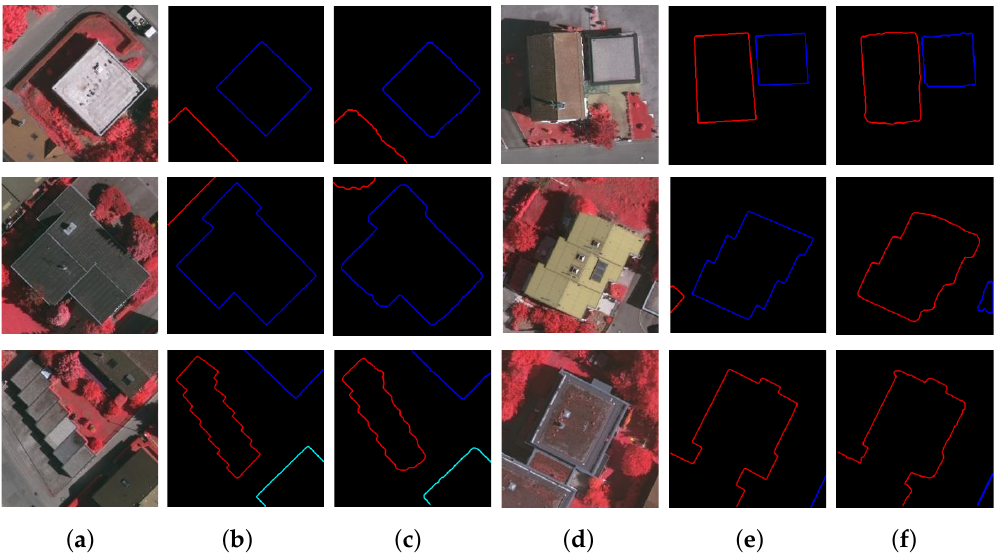
Figure 5. Contour curve extraction on 6 aerial images: ( a , d ) test images; ( b , e ) ground-truth curves; ( c , f ) results generated and used in our corner detection